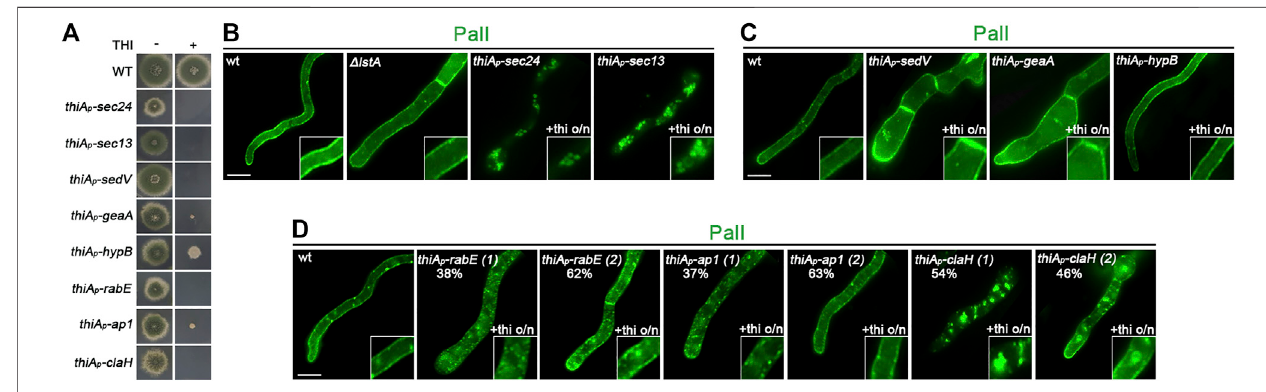
FIGURE 7 | Subcellular localization of neosynthesized PalI in traf fi cking mutant backgrounds. (A) Growth tests showing that, in the presence of thiamine in the growthmedium,strainsselectedtostudythe donovo localizationofPalI-GFPdonotformpropercolonies,con fi rmingthatallgenesexpressedunderthe thiA p promoter are tightly repressed. In the absence of thiamine from the growth medium (derepressed conditions), the corresponding strains grow nearly as an isogenic wild-type control. (B) Epi fl uorescenceanalysisof denovo -madePalI-GFPwhenthetranscriptionof sec24 or sec13 isrepressedor lstA isgeneticallydeleted.Transcriptionof sec24 and sec13 was ab initio blocked by the addition of thiamine in the media. It is noted that PalI is properly localized at the PM in the Δ lstA background, whereas it is dramatically abolished when sec24 and sec13 are repressed. (C) Epi fl uorescence analysis of de novo -made PalI-GFP when sedV , geaA , or hypB transcription is repressed by ab initio addition of thiamine. PalI-GFP translocates to the PM in all cases. (D) Epi fl uorescence analysis of de novo -made PalI-GFP when rabE, ap-1 σ , or claH transcriptionisrepressedby ab initio addition thiamine. PalItranslocation tothePMwasdetected when rabE or ap-1 σ wasrepressed inthemajorityofgermlings or hyphae(n=100).Inaminorityofhyphae,PalI-GFPlabeledstaticcytoplasmicstructures,possiblymembranousaggregates.Repressionof claH transcriptionsigni fi cantly blocked PalI-GFP translocation to the PM in the majority of cells. Scale bars: 5 μ m.